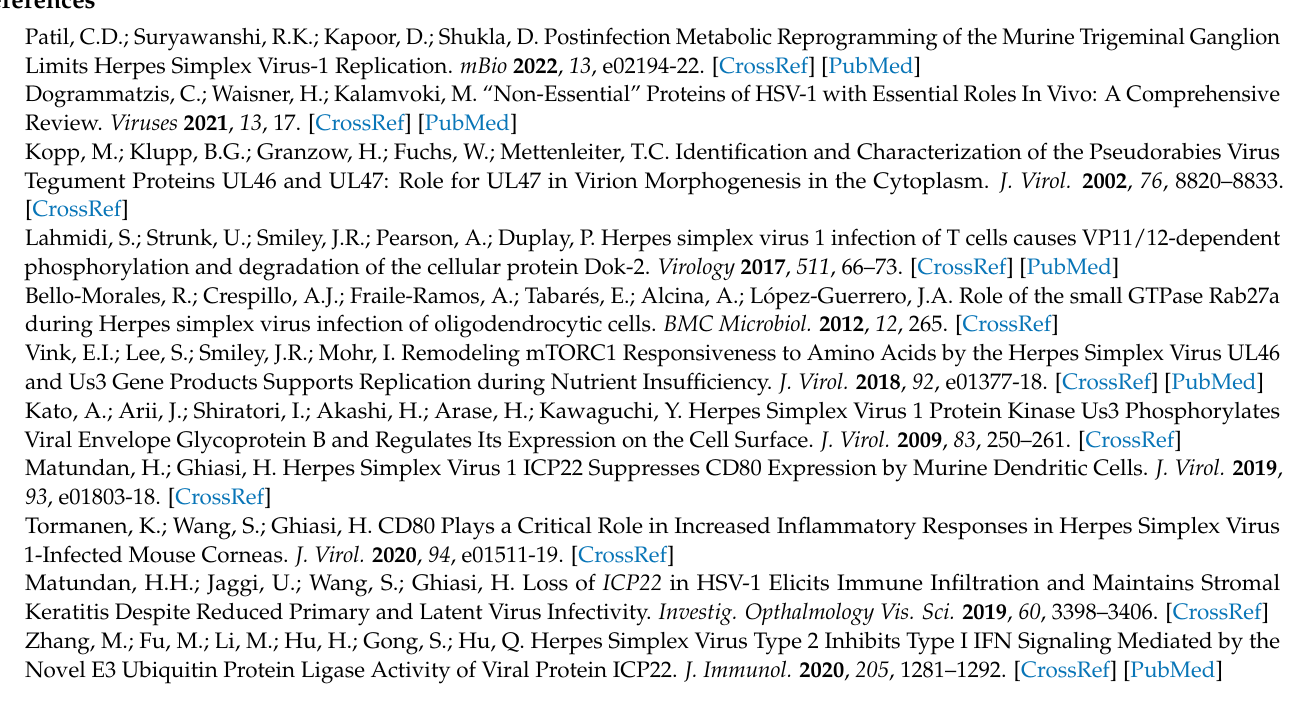
PCR; Table S2: Functions of candidate genes in human; Table S3: Peptide Mass of